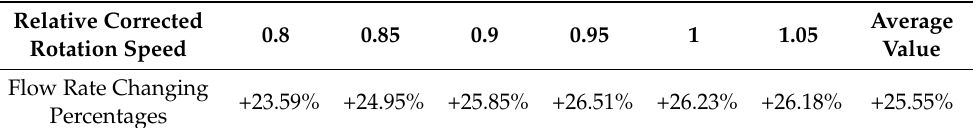
Table 4. The Flow Rate Changing Percentages while Inlet Guide Vane Angle of AFS Changes from − 30 ◦ to 0 ◦ .